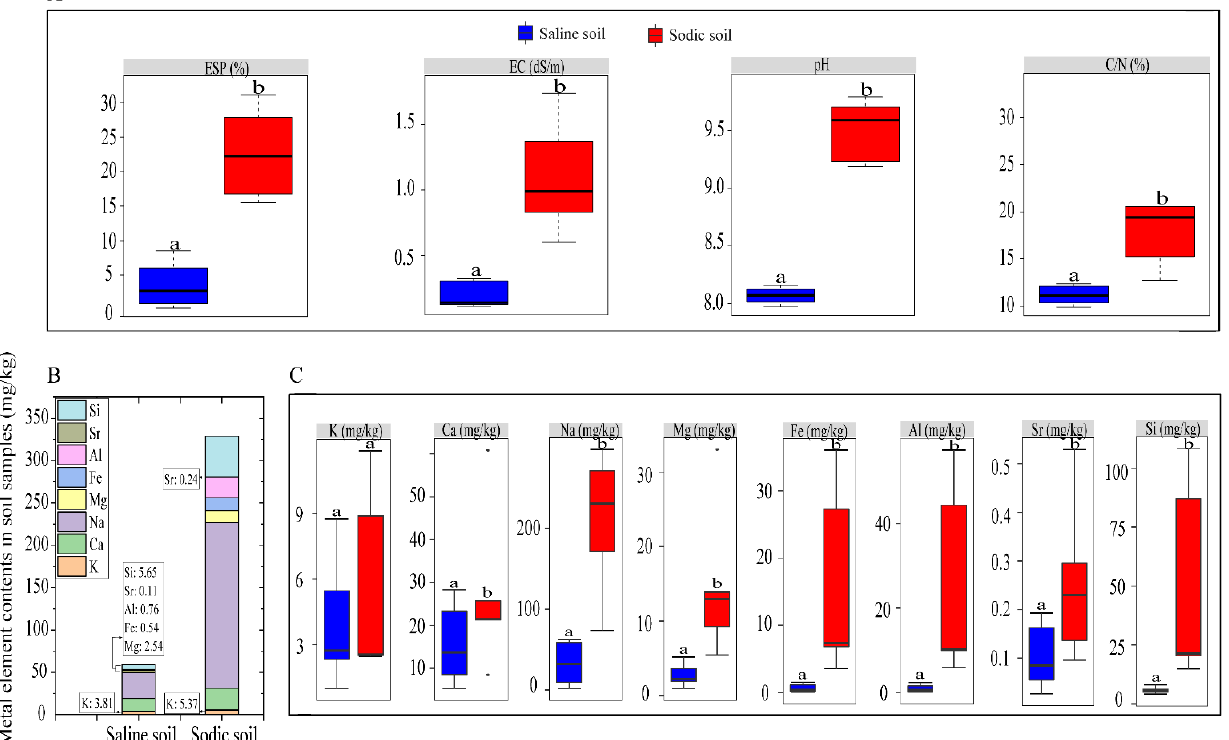
Figure 1. ( A ) Basic physicochemical properties of soil samples ( t -test, p < 0.05). ( B ) Soil content of metal elements. (C) differences in saline and sodic soil ( t -test, p < 0.05). Table 1. Comparison of alpha diversity between saline soil and sodic soil samples. Sample